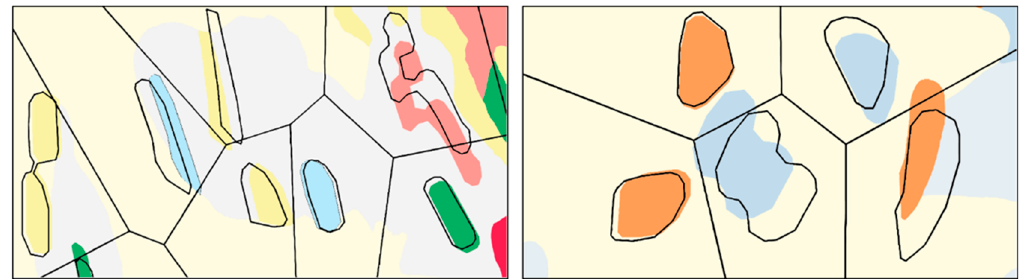
Figure 8. Voronoi-based algorithm. ( a ) Original polygons. ( b ) Generation of Voronoi polygons used to propagate displacement. ( c ) An overlay of the original and displaced polygons. Figure 9 features two examples of the application of the Voronoi-based displacement algorithm with both the original and displaced polygon positions shown.